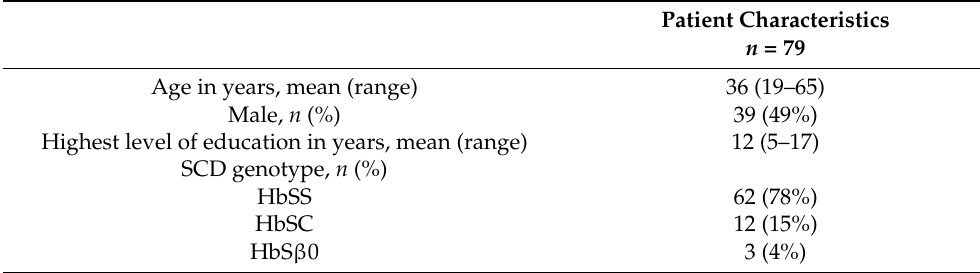
Table 2. Characteristics of the patients included in the prospective